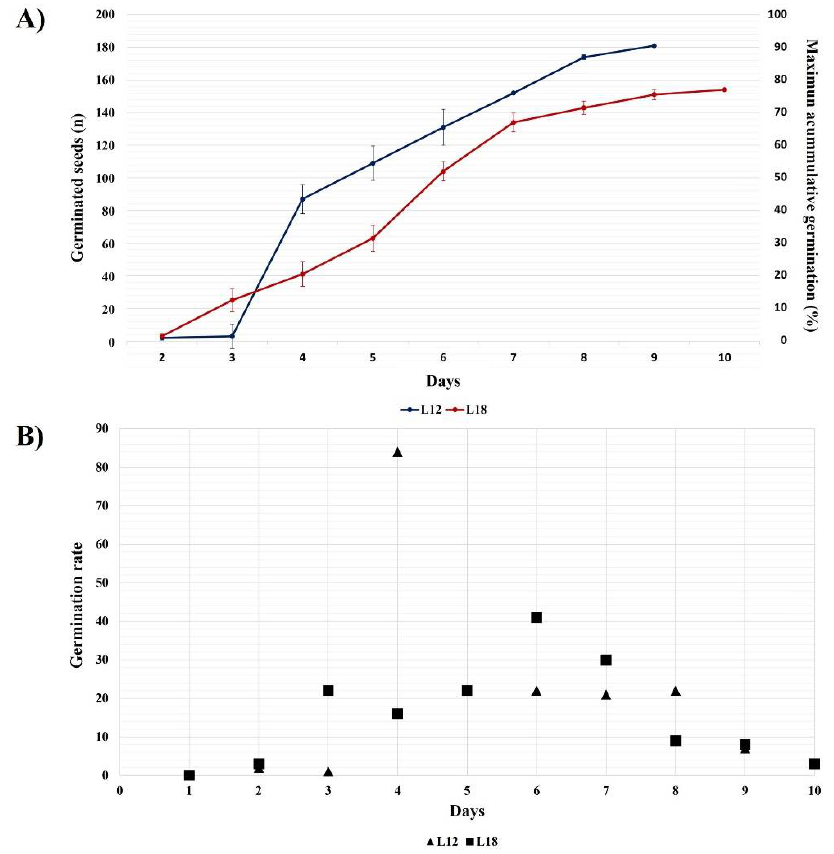
Figure 1. Accumulative germination rate and final germination percentage of the two A. marmorata seed lots without plant growth regulators or scarification treatment. ( A ) The number of germinated seeds and the percentage of accumulative germination, and ( B ) the germination rates. The L12 reached the maximum rate on day 4, with 87 seeds germinating, and the final percentage was 90% on day 9. The L18 seeds had the best germination rate on day 6, but the selected seedlings were taken from day 3. The final percentage for L18 seeds was 13% lower than for L12. The data are expressed as the mean ± SD of three independent replicates with 200 seeds per